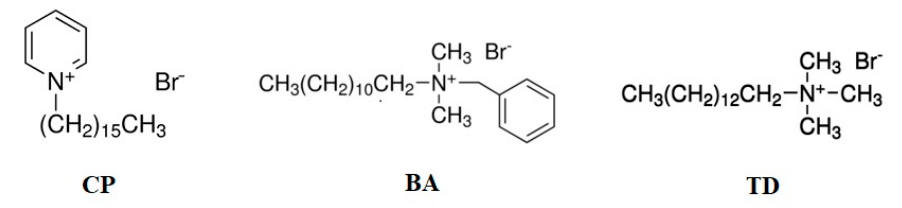
Figure 1. The structural formulas of used organic surfactants [34].